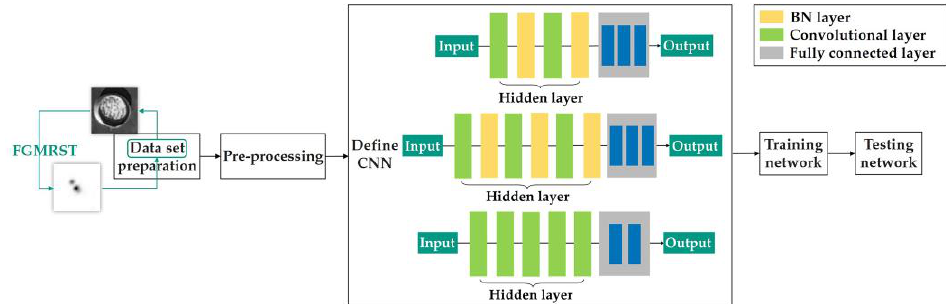
Figure 11. Flow chart of tandem method.